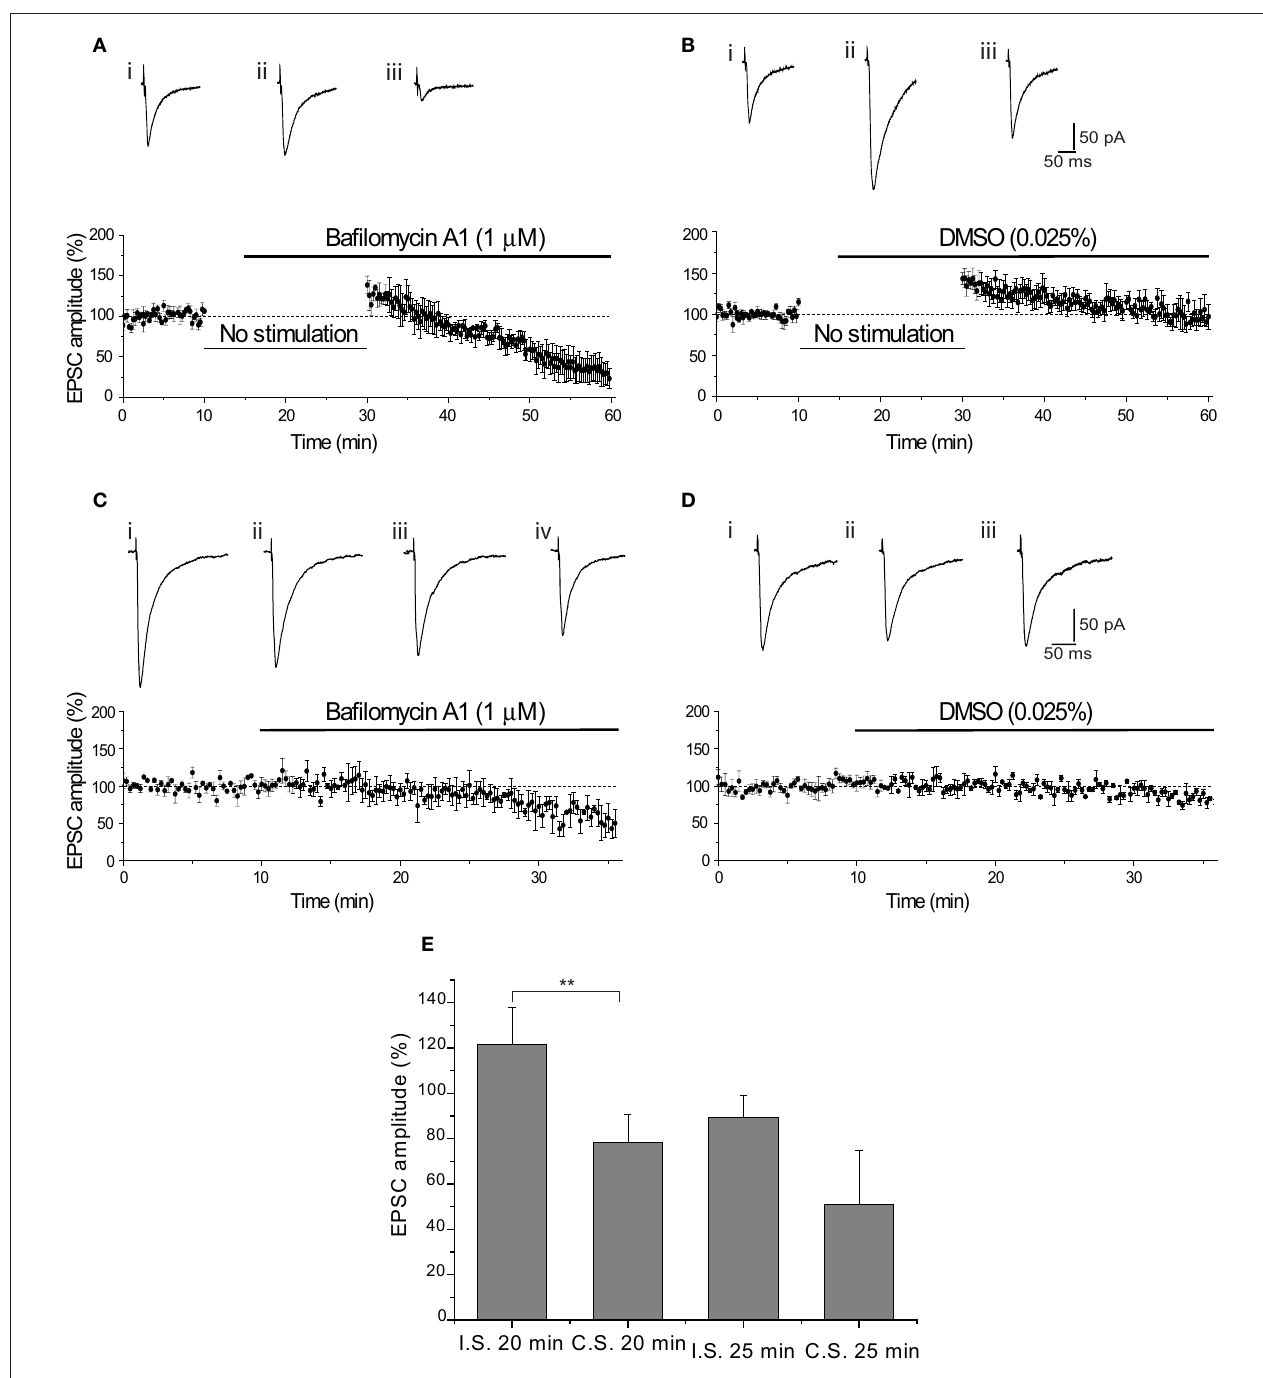
Figure 7 | Vesicle depletion does not underlie the reduction of ePSC amplitude. ( A) Bafilomycin A1 (Baf A1) did not reduce the amplitude of the EPSC after resuming stimulation. The initial augmentation in the presence of Baf A1 (1 μM) ( + 38.6 ± 10.9%, n = 4) shows that storage of glutamate was not affected by the protocol. Representative EPSCs show the final baseline EPSC (i), the first EPSC evoked in Baf A1 (ii) and the final EPSC evoked in Baf A1 (iii). (B) The vehicle control (0.025% DMSO) augmented EPSC amplitude on stimulating after 15 min cessation ( + 43.3 ± 7.3%, n = 6). Representative EPSCs show the final baseline response (i), the first response evoked in DMSO (ii)